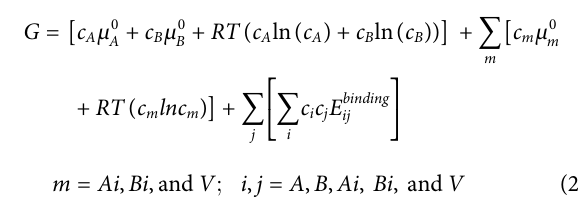
Frontiers in Materials |